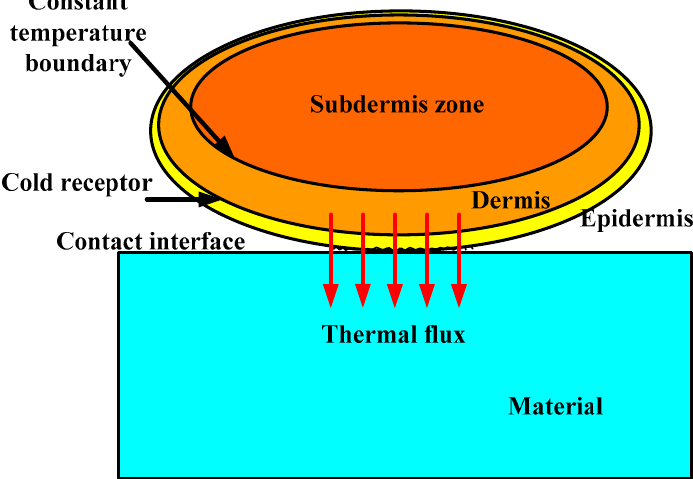
Figure 1. The condition of contact between a fingertip and a